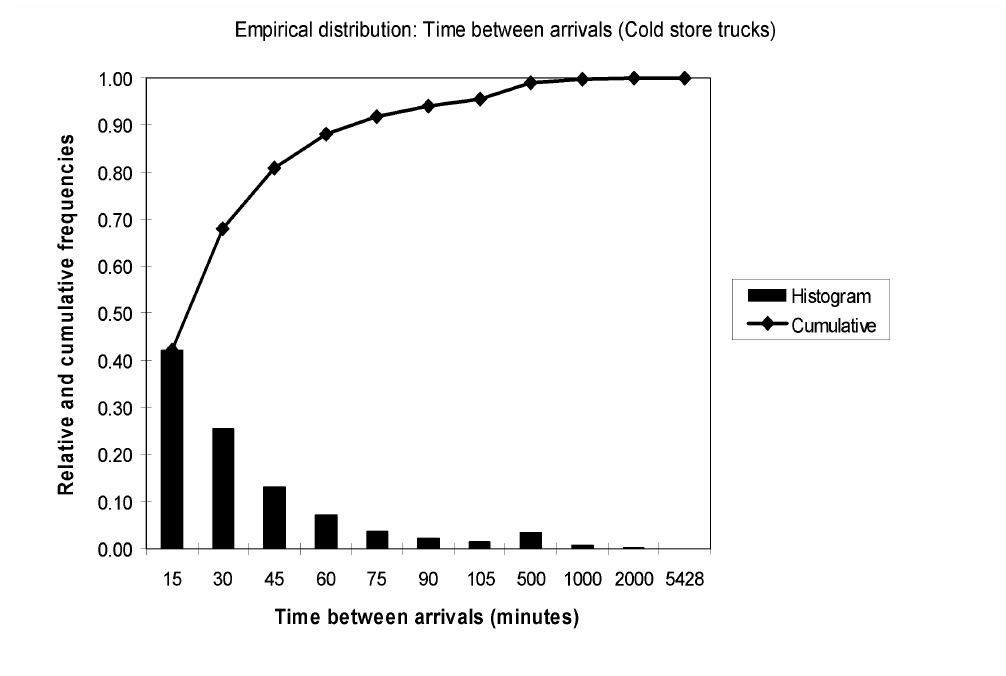
Figure 3: Histogram and empirical distribution: Time between arrivals (Cold